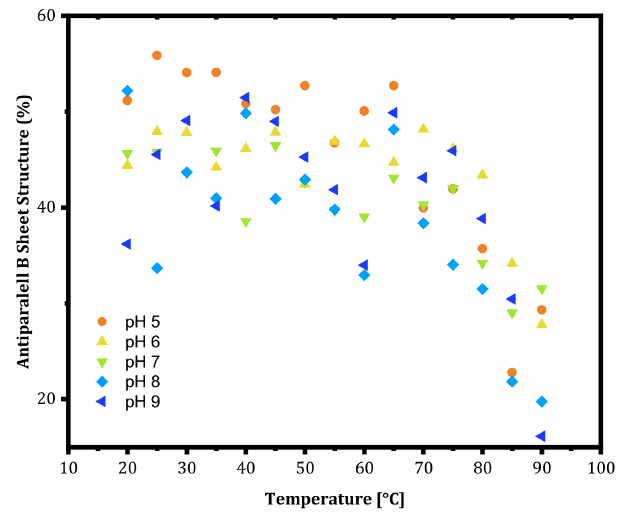
Figure 3. Temperature-dependent percentage change of antiparallel β sheets at different pH.